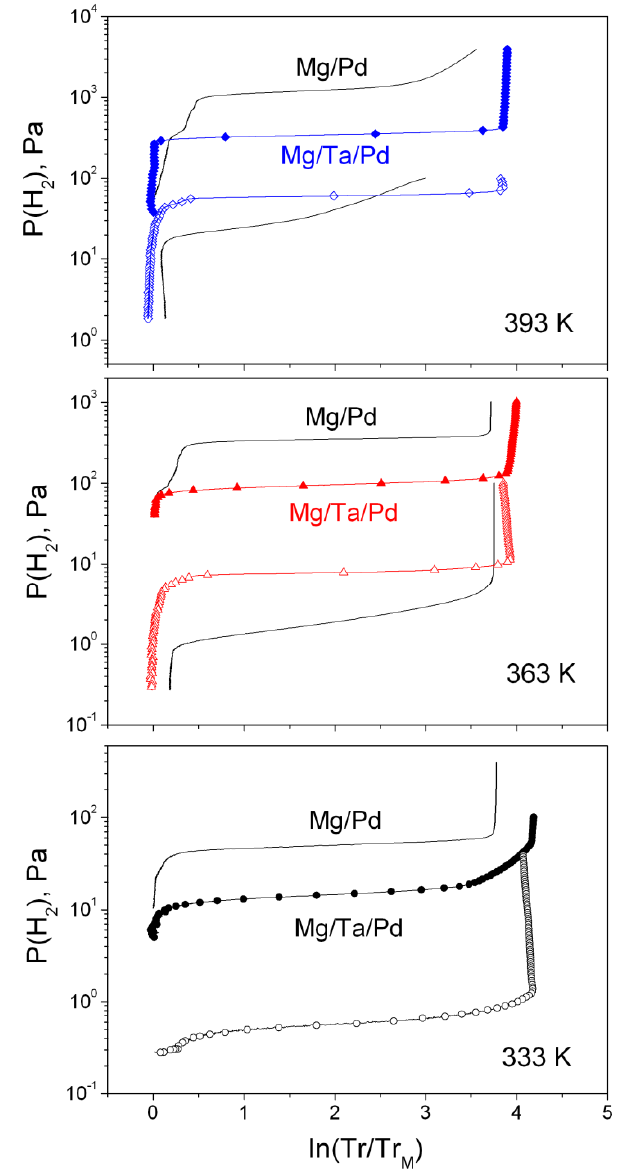
Figure 8. Comparison between Pressure-Transmission-Isotherms (PTI’s) of the Mg/Pd and Mg/Ta/Pd films in the temperature range 333–393 K. Solid and solid + symbol lines represent (de-)hydrogenation behavior of Mg/Pd and Mg/Ta/Pd films,